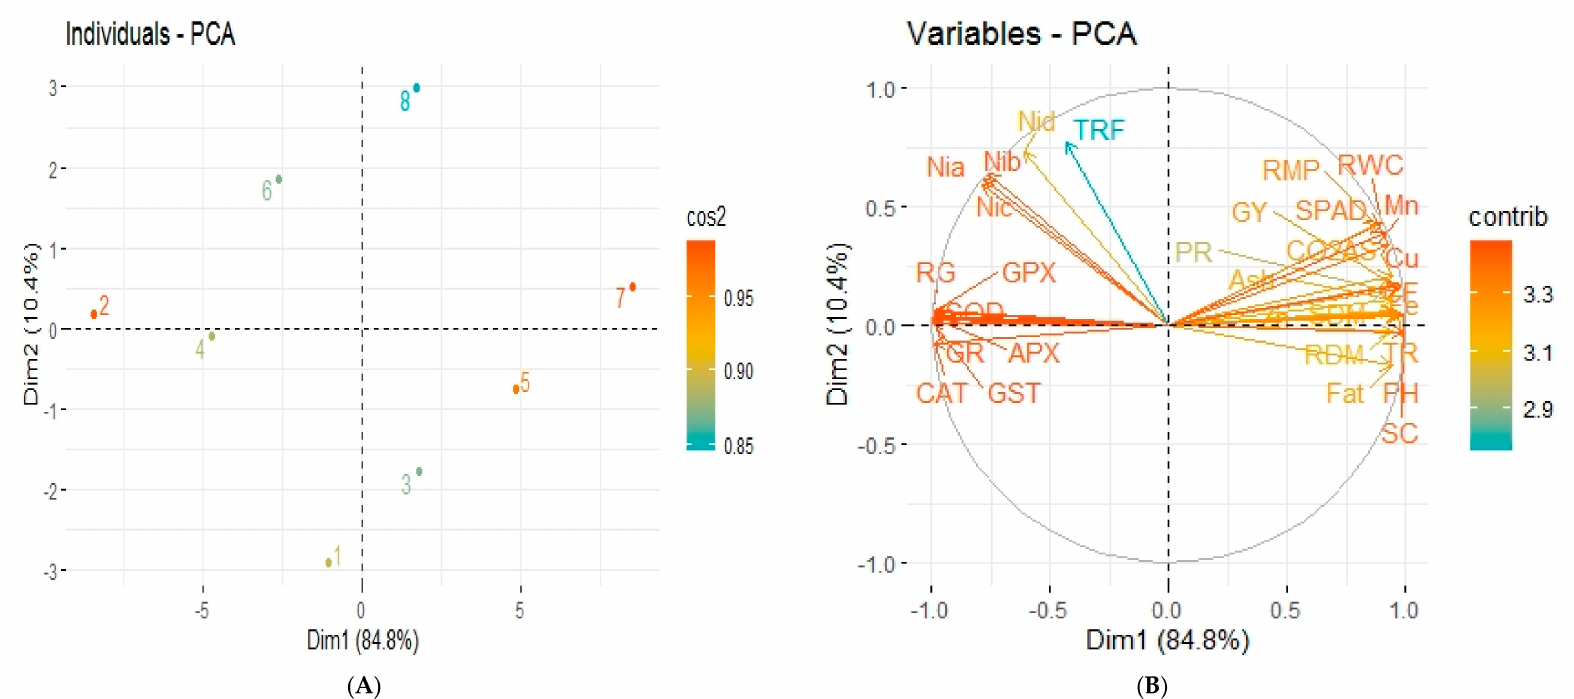
Figure 6. Principal component analysis (PCA) showing score plots ( A ) and loading plots ( B ) of di ff erent attributes of sesame plants. Score plots (A) represents separation of treatments as control, (1) Ni 0 mg kg − 1 (2) Ni 90 mg kg − 1 ; zeolite, (3) Ni 0 mg kg − 1 (4) Ni 90 mg kg − 1 ; Caulobacter sp. MN13, (5) Ni 0 mgkg − 1 (6) Ni 90 mg kg − 1 ; Caulobacter sp. MN13 + zeolite, (7) Ni 0 mg kg − 1 (8) Ni 90 mg kg − 1 .The abbreviations are as PH: plant height, RDM: root dry biomass, SDM: shoot dry biomass, GY: grain yield, CO 2 AS: CO 2 assimilation rate, TR: transpiration rate, SC: stomatal conductance, SPAD: chlorophyll contents, RG: Reduced glutathione, GPX: Glutathione peroxidase, GR: Glutathione reductase, GST: Glutathione S transferase, APX: Ascorbate peroxidase, CAT: catalase, SOD: superoxide dismutase, Ash: Ash %, CF: crude fiber %, PR: protein %, Fat: fat%, Nia: Ni in grain, Nib: Ni in shoot, Nic: Ni in root, Nid: Ni in soil, Zn: Zn in shoot, Fe: Fe in shoot, Cu: Cu in shoot, Mn: Mn in shoot, RWC: relative water contents, RMP: relative membrane permeability, and TRF: translocation